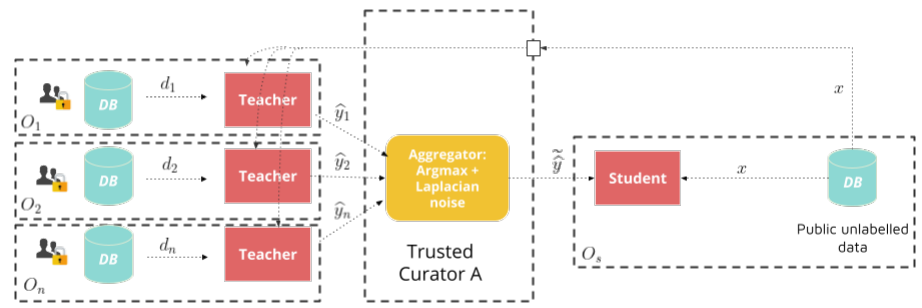
Figure 4. Private Aggregation of Teacher Ensembles